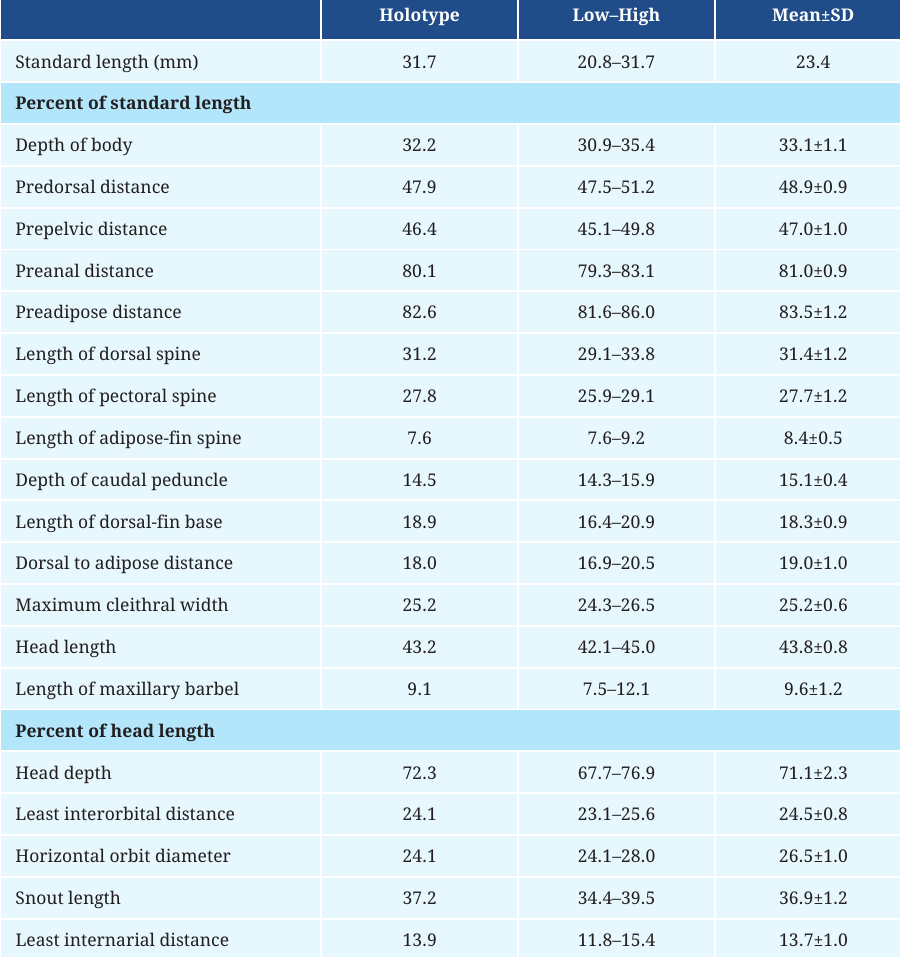
TABLE 2 | Morphometric data of the holotype and 19 paratypes of Corydoras hypnos . SD = Standard